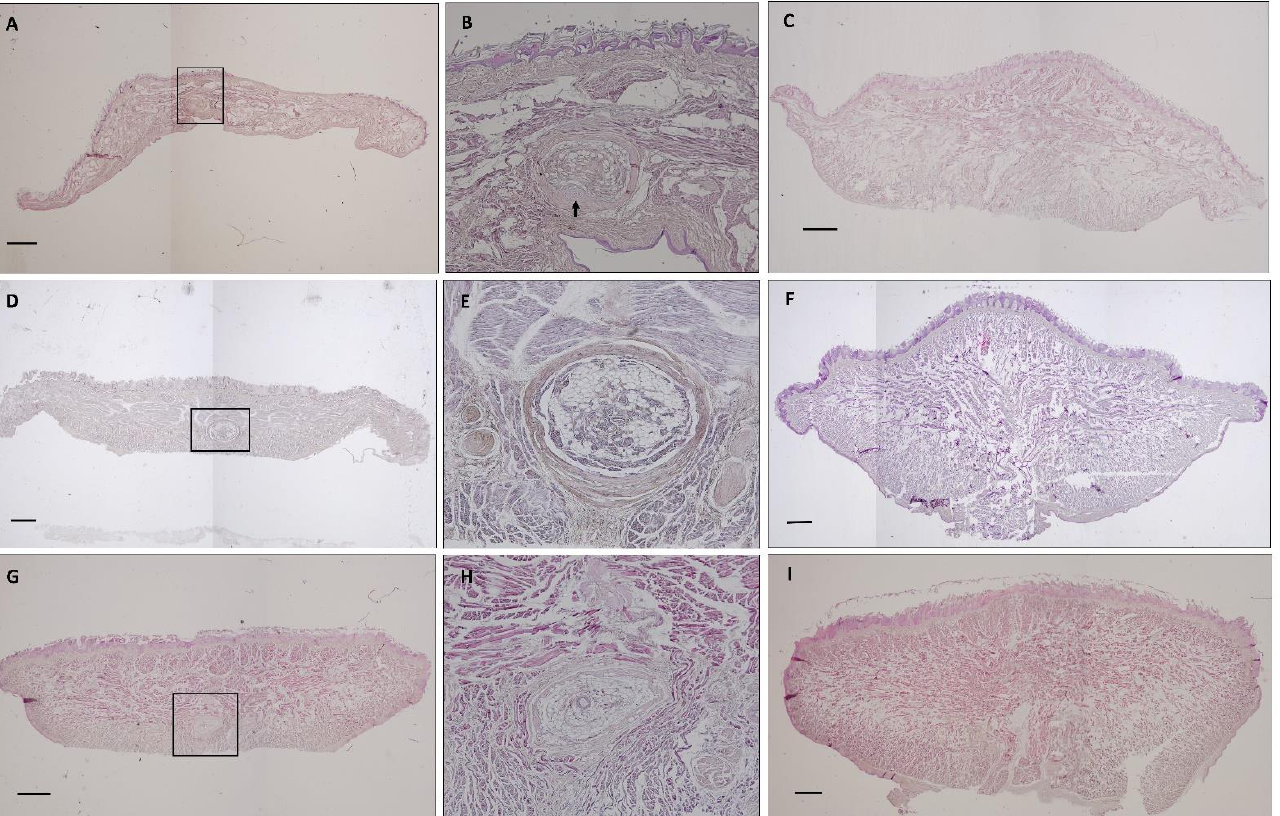
Figure 4. Photocomposition of a frontal section of the tongue’s body at the level of the anterior third (images A , D , G ) or posterior third (images C , F , I ) in Lemur catta (images A , B , C ), Varecia variegata (images D , E , F ) and Eulemur macaco (images G , H , I ). Images ( B , D , H ) shown a magnification of the area framed in images ( A , D , G ), focusing on the encapsulated organ found in the antero-ventral position of the tongue in all species studied. Arrow in image ( B ) points to the presence of an cartilage only in Lemur catta . All sections were stained with hematoxylin—eosin. Scale bar 1 mm.